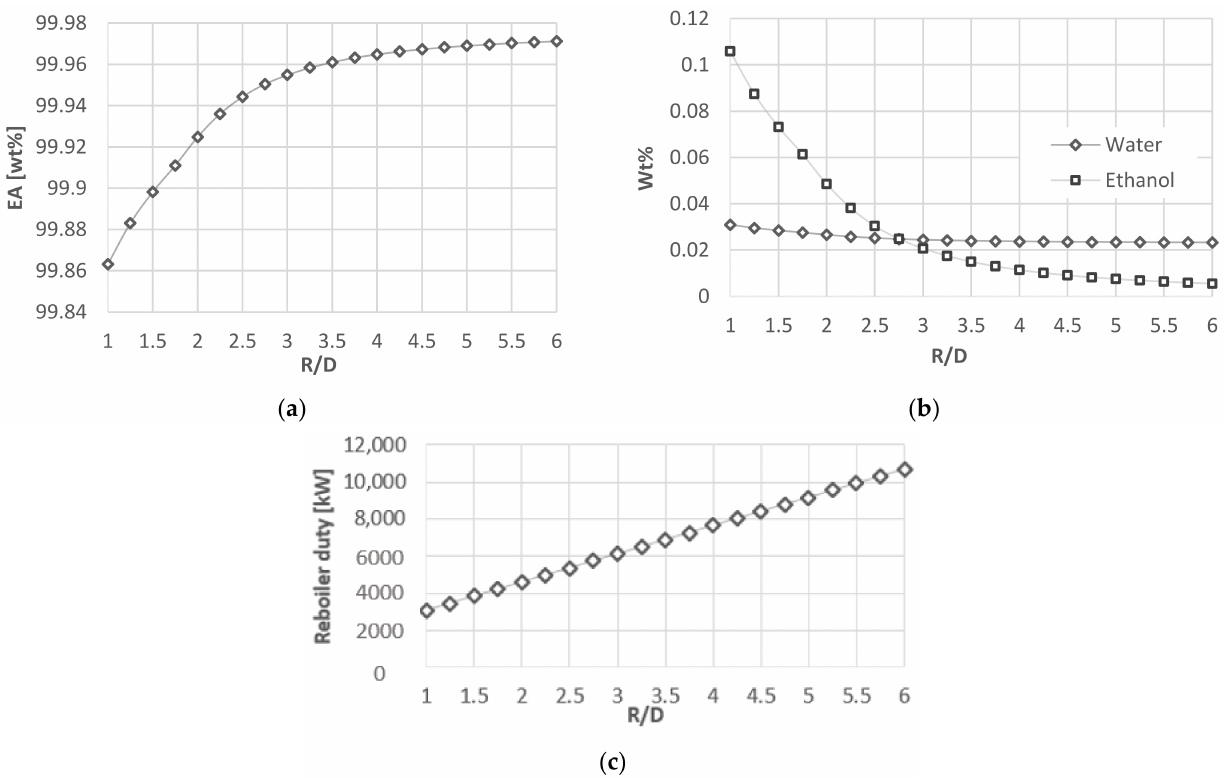
Figure 5. The effect of R/D ratio on ( a ) the EA content in the product; ( b ) the water and ethanol content in the product; ( c ) reboiler